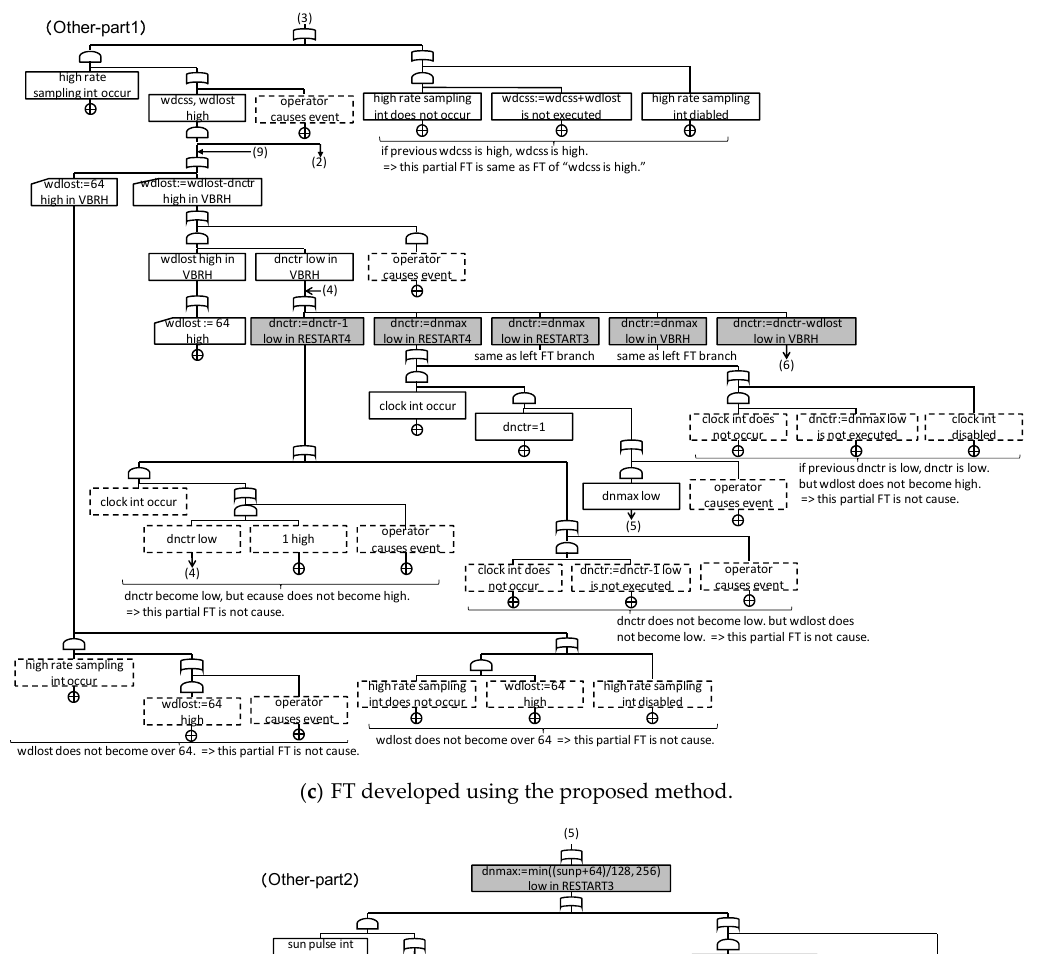
( c ) FT developed using the proposed method.